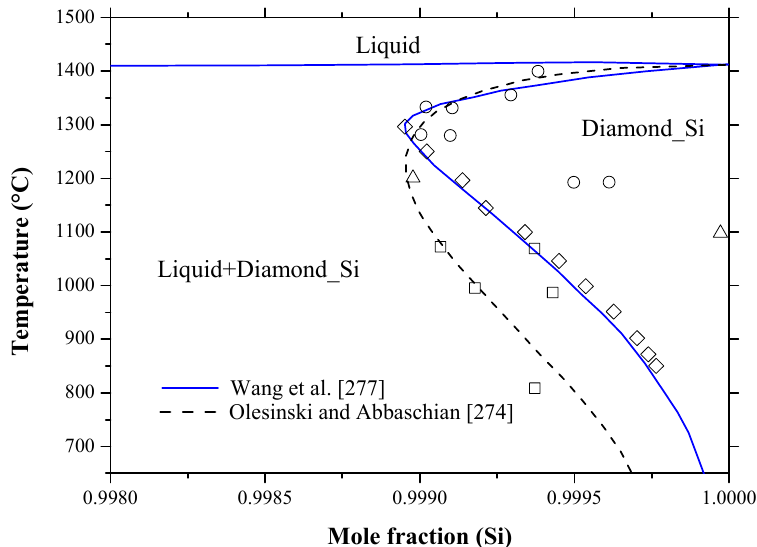
: [177]; (cid:3) : [275]; ∆ : [120]; ♦ : [178]. (cid:35)